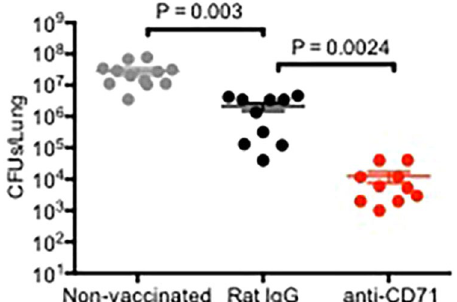
Figure 6. Depletion of CD71 + cells prior to immunization provides protection against infection with B. pertussis . Recoverable bacteria in the lungs of mice after infection with B. pertussis (5 × 10 6 CFUs) in non- vaccinated control versus CD71 + cells depleted or isotype treated mice after vaccination. Each point represents data from an individual mouse, representative of three independent experiments. Bar, mean ± one standard